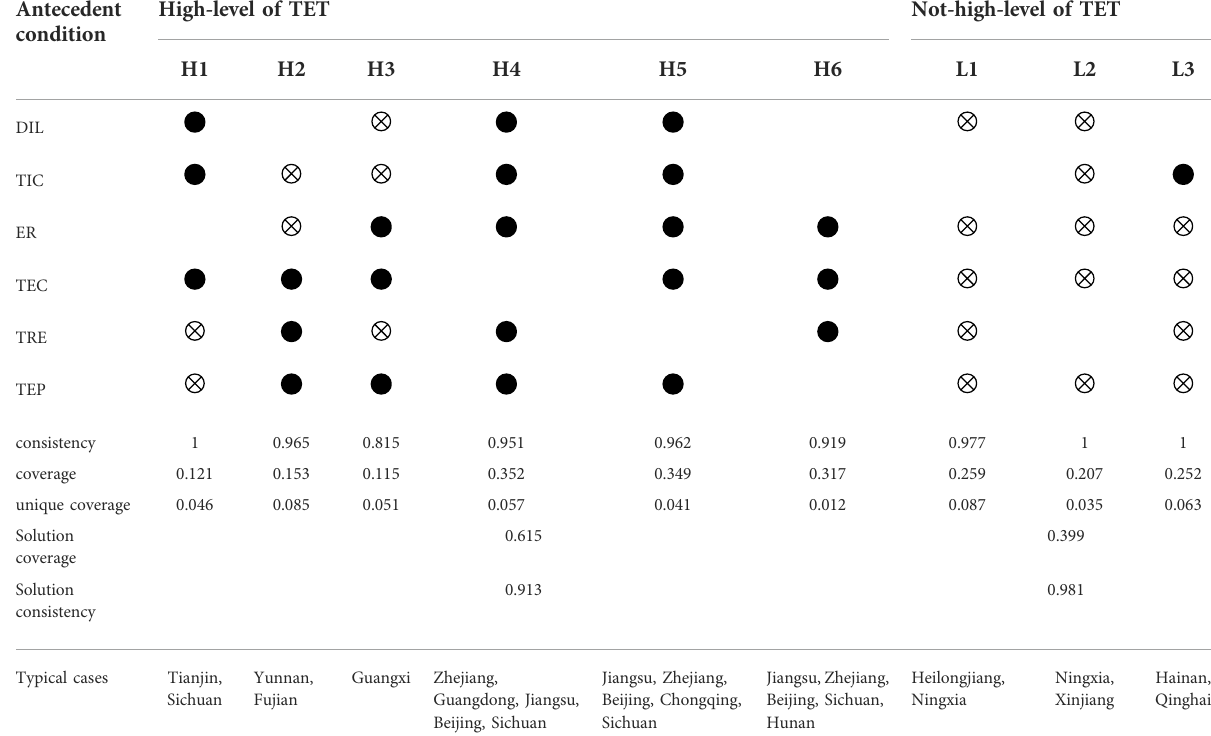
TABLE 4 Con fi gurational conditions strongly related to